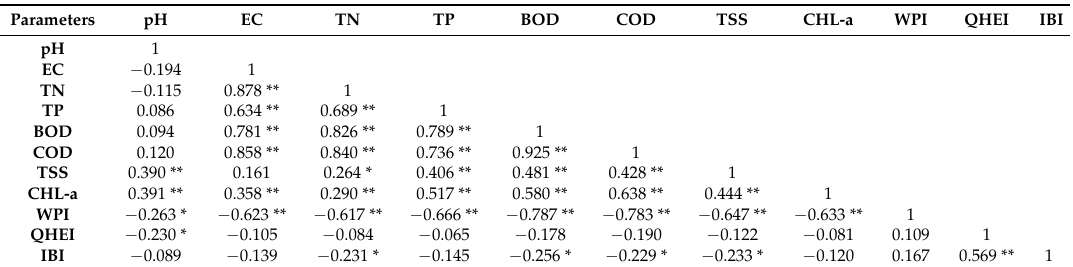
Table 7. Correlation analysis on selected water quality parameters and indices used in Gap Stream during 2007–2016.